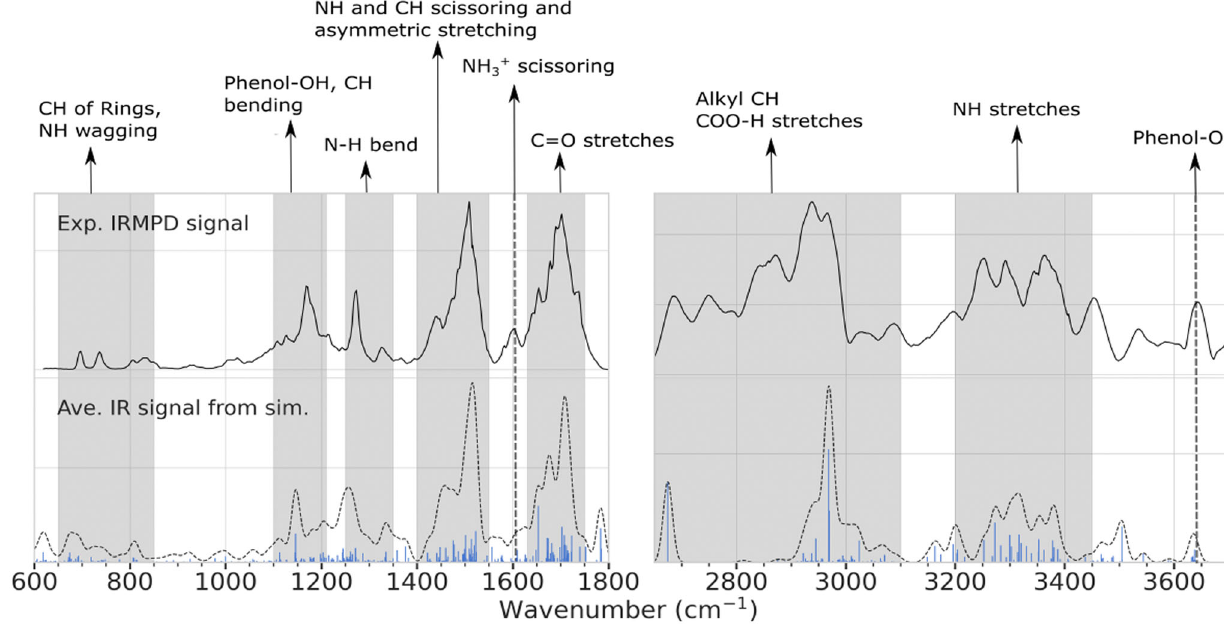
Fig. 3 Comparison between experimental IRMPD and predicted average IR spectra using the PAMM conformers. Calculated IR intensities are convoluted by Gaussians with a 10 cm − 1 full-width of half-maximum. Pendry reliability factors R P are 0.56 for the left panel and 0.7 for the right